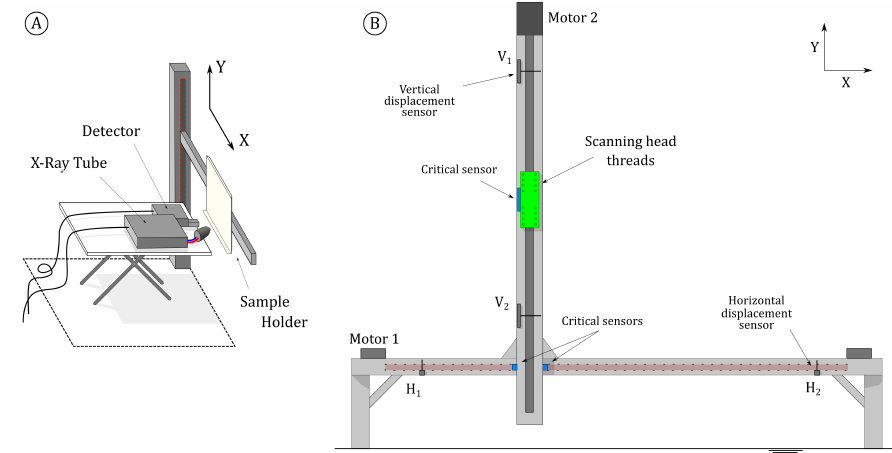
Figure 2. Translation stages: portable version ( A ) and mobile version ( B